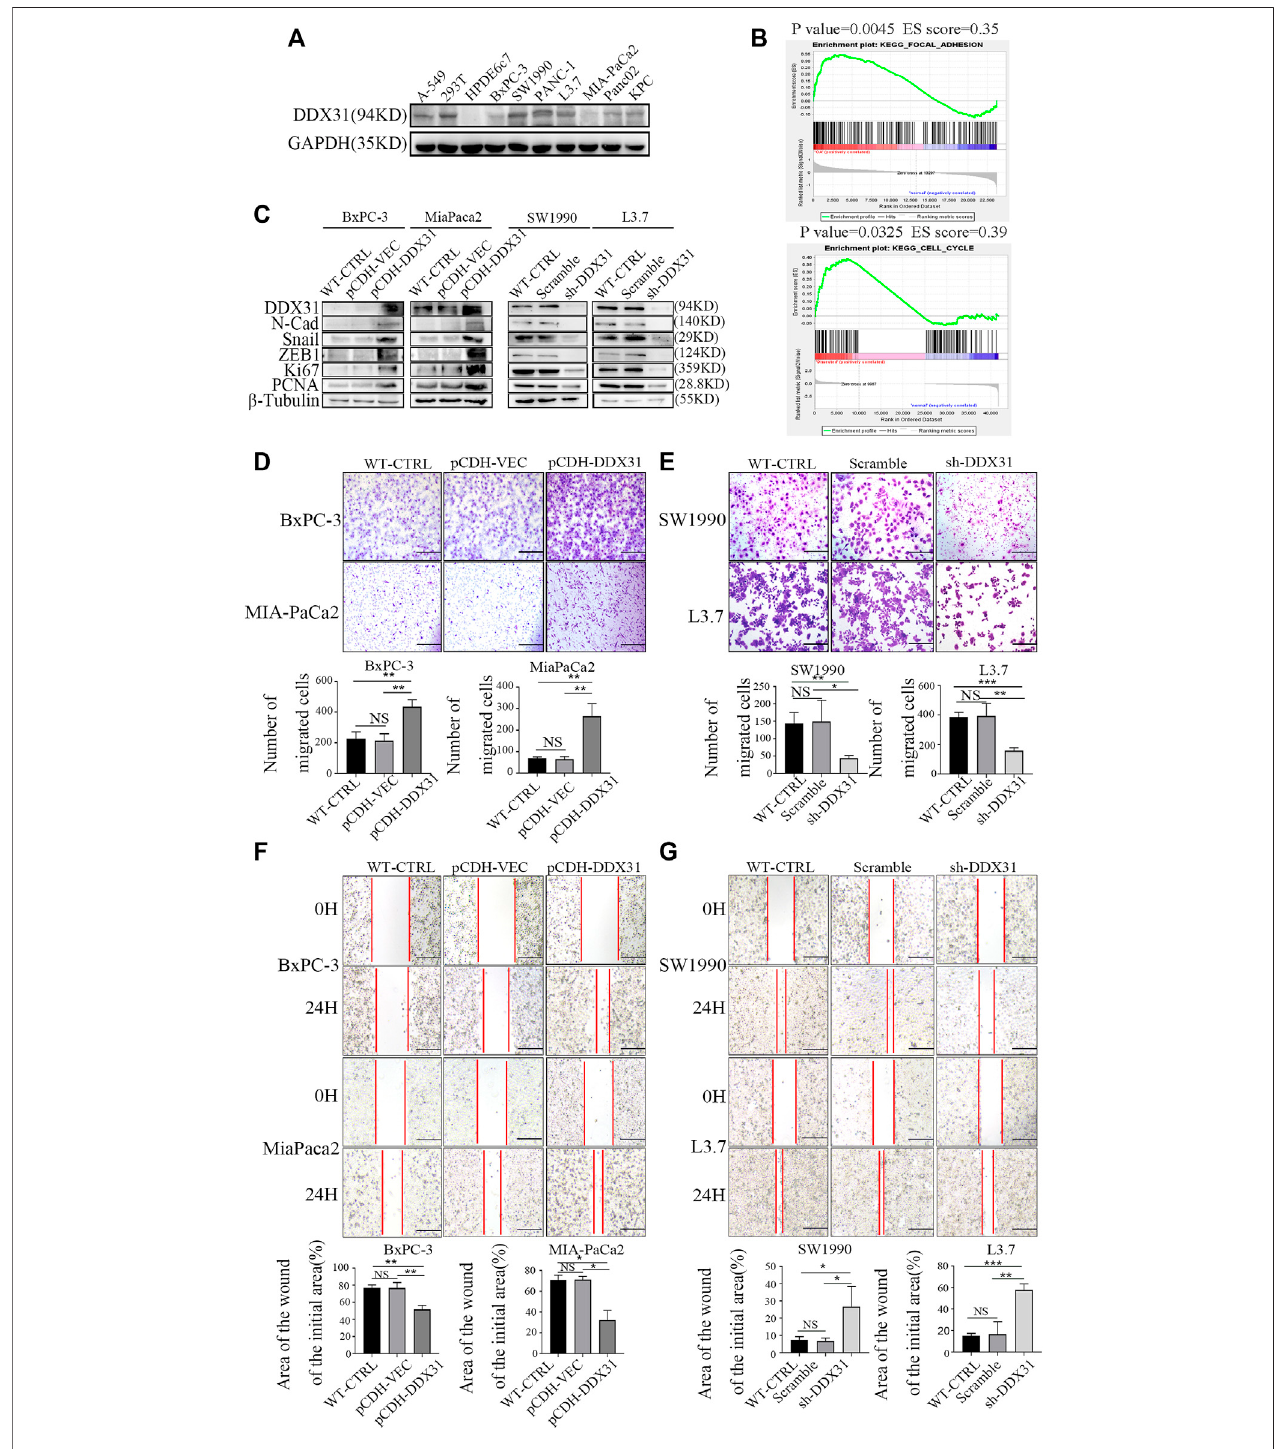
FIGURE6| DDX31 promotedPDACcellmigration. (A) :Thebasicproteinexpressionof DDX31 inallPDACcelllineswasmeasuredwithWesternblotanalysis. (B) : GSEA wascarried outaccording tothe expression level of DDX31 ; p value < .05, FDR < 0.25. (C) : Loss and gain-of-function studies according tothe results ofWestern blot analysis were performed ( DDX31 overexpression on BxPC-3/MIA-PaCa2 cell lines, DDX31 knockdown on SW1990/L3.7 cell lines). (D,E) : Cell migration was detected by transwell assays (bar = 200 μ m) and wound healing experiments (bar = 200 μ m) in DDX31 -overexpression PDAC cell lines BxPC-3 and MIA-PaCa2. (F,G) :Transwellassayandwoundhealingassaywereperformedwhen DDX31 wasdownregulatedinPDACcells(SW1990andL3.7).Imageswerecollectedthreetimes randomlyfromeachexperiment(overexpression,left;knockdown,right).TheFigureureatthebottomshowsthecorrespondingstatisticalchart(unpairedt-tests).Values are presented as the means ± SDs of three independent experiments. * p < 0.05, ** p < .01, *** p < .001, **** p < .0001, and NS means non signi fi cant.